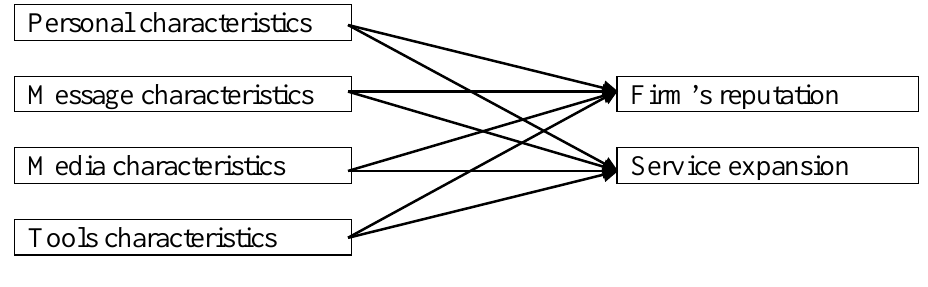
Fig. 1. The proposed